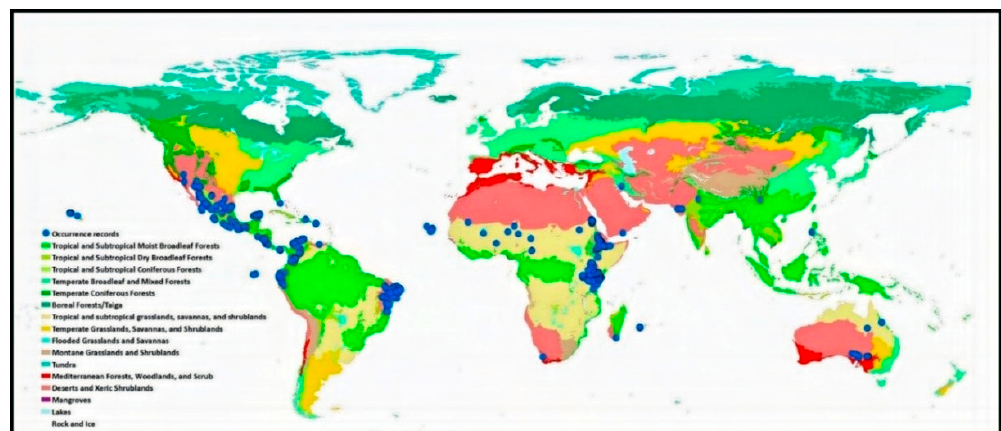
Figure 1. Global distribution of the sixteen terrestrial biomes and the occurrence records of P. juliflora .